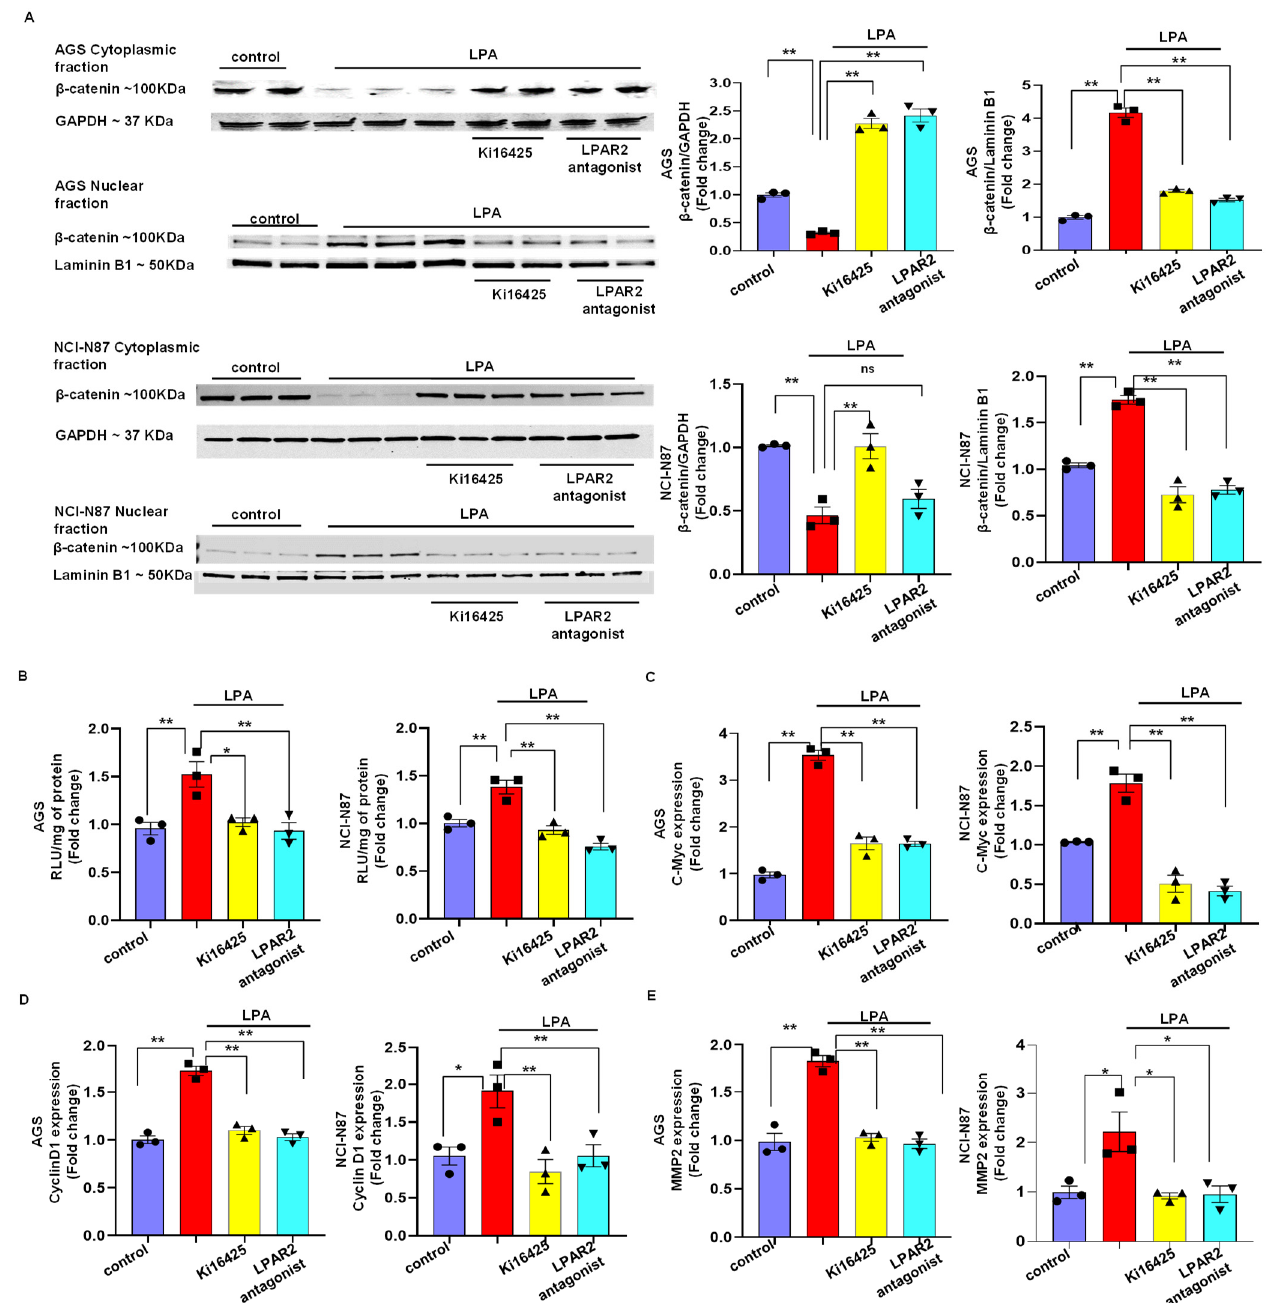
Figure 3. LPA treatment activated the β -catenin signaling pathway through the LPAR2 receptor. ( A ) The cytoplasmic and nuclear fraction of AGS ( upper ) and NCI-N87 cells ( lower ) were loaded on an SDS-PAGE gel and β -catenin was detected using Western blotting. We used GAPDH and laminin B1 as fractionation and loading controls. ( B ) Luciferase assay examining the effect of LPA, Ki16425 or LPAR2 antagonist in AGS ( left ) and NCI-N87 ( right ) cells. RLU, relative light unit. ( C ) Effect of LPA receptor antagonists on LPA-induced increased expression in the target genes of the β -catenin signaling pathway in AGS ( left panel of C – E ) and NCI-N87 ( right panel of C – E ) cell line. All values are mean ± SD ( n = 3). * p < 0.05, ** p < 0.01 compared to the control. Student’s t -test was used for comparisons between two groups; one-way ANOVA followed by the Bonferroni post hoc test was performed for more than two groups.